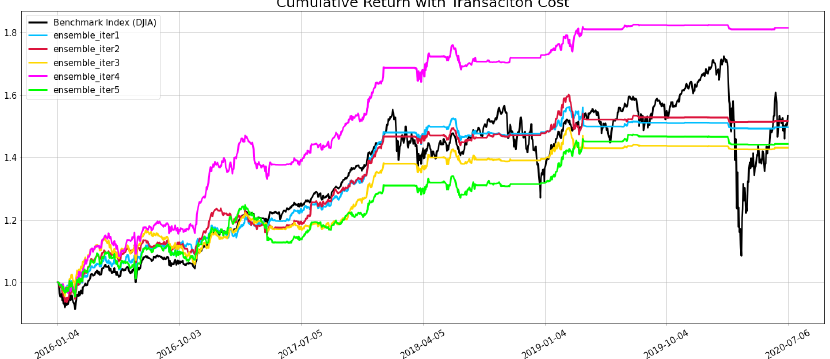
Figure 6. Cumulative return curves of the original ensemble strategy agent and DJIA ( h max = 100, buying threshold = 0, selling threshold = 0, initial portfolio value $1,000,000, from 4 January 2016